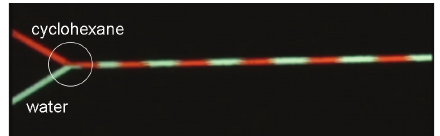
Figure 2: Experimental photograph for the segment flow in a Y- shaped microchannel at ℎ = 200 𝜇 m, | ⃗𝑢 01 | = | ⃗𝑢 02 | = 0.025 m/s and = 𝜑 = 30 ∘ . Red: cyclohexane; green: water. 𝜑 1 2